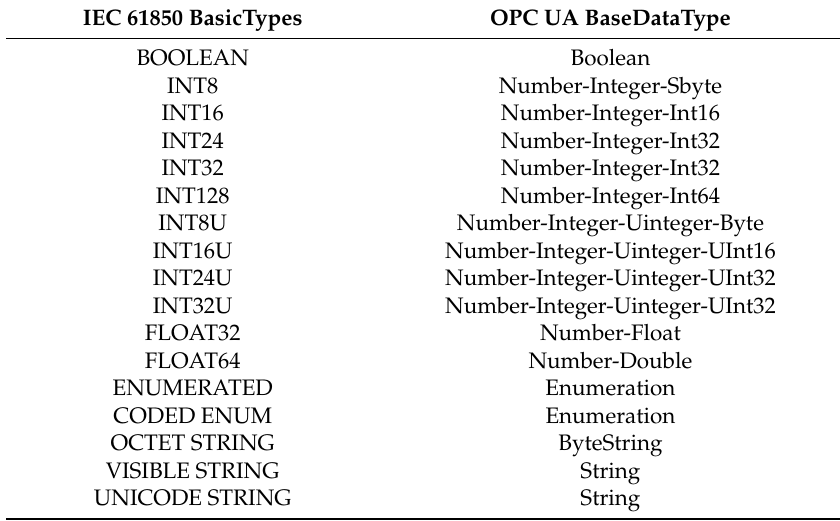
Table 2. Data-type